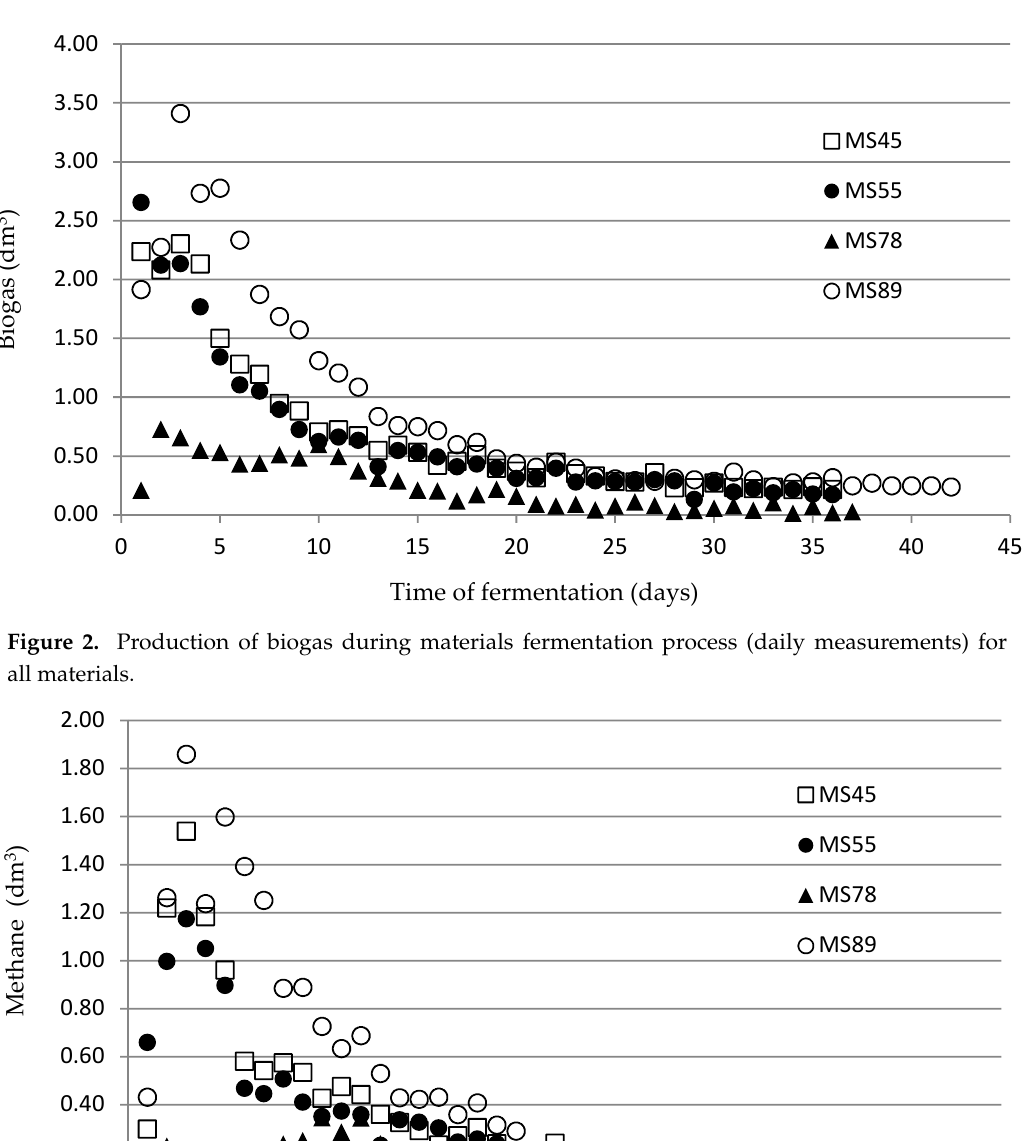
Figure 3. Methane production during fermentation process (daily measurements) for all materials.